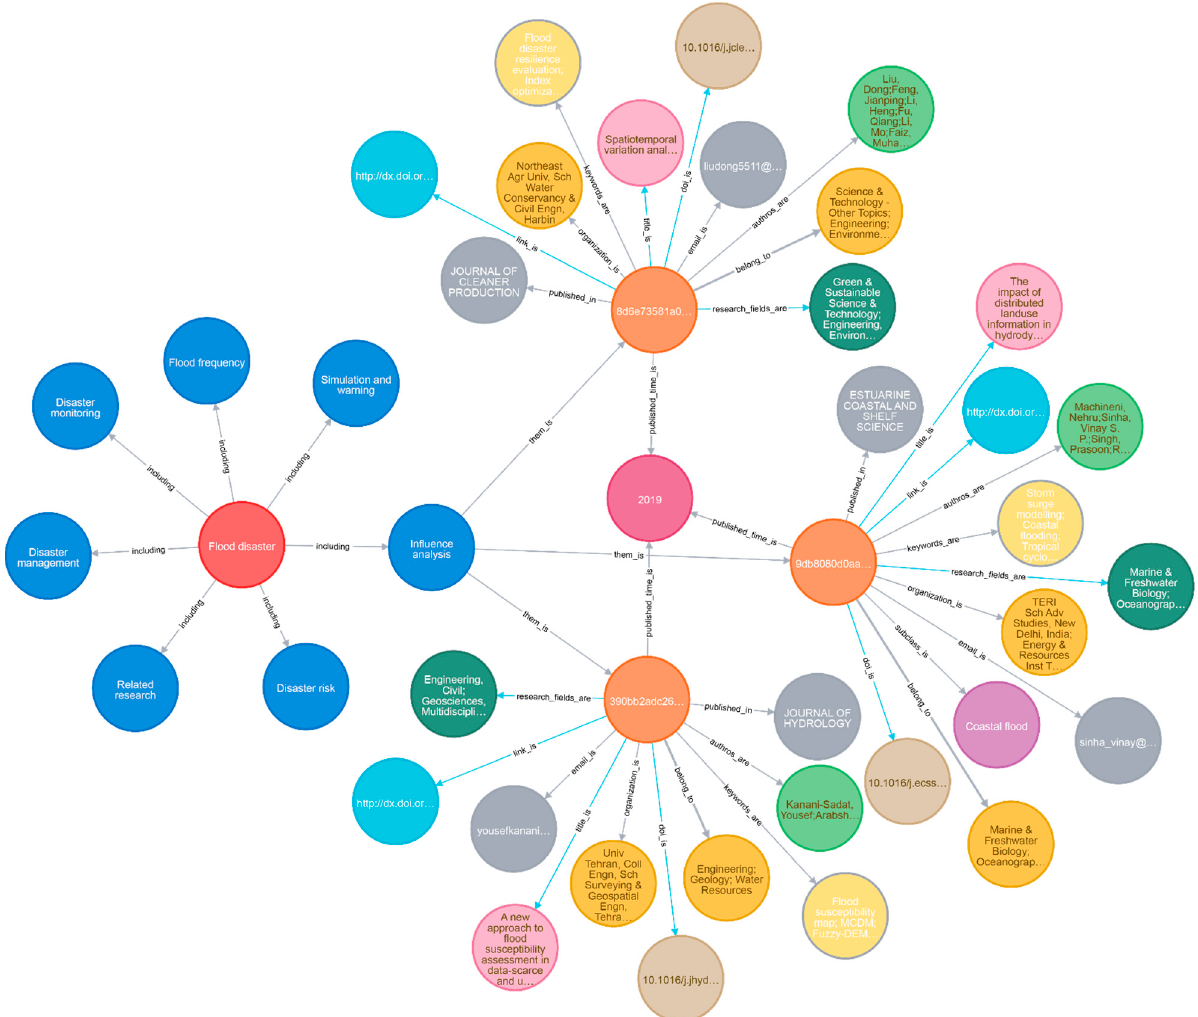
Figure 7. Visualization of flood disaster knowledge graph.